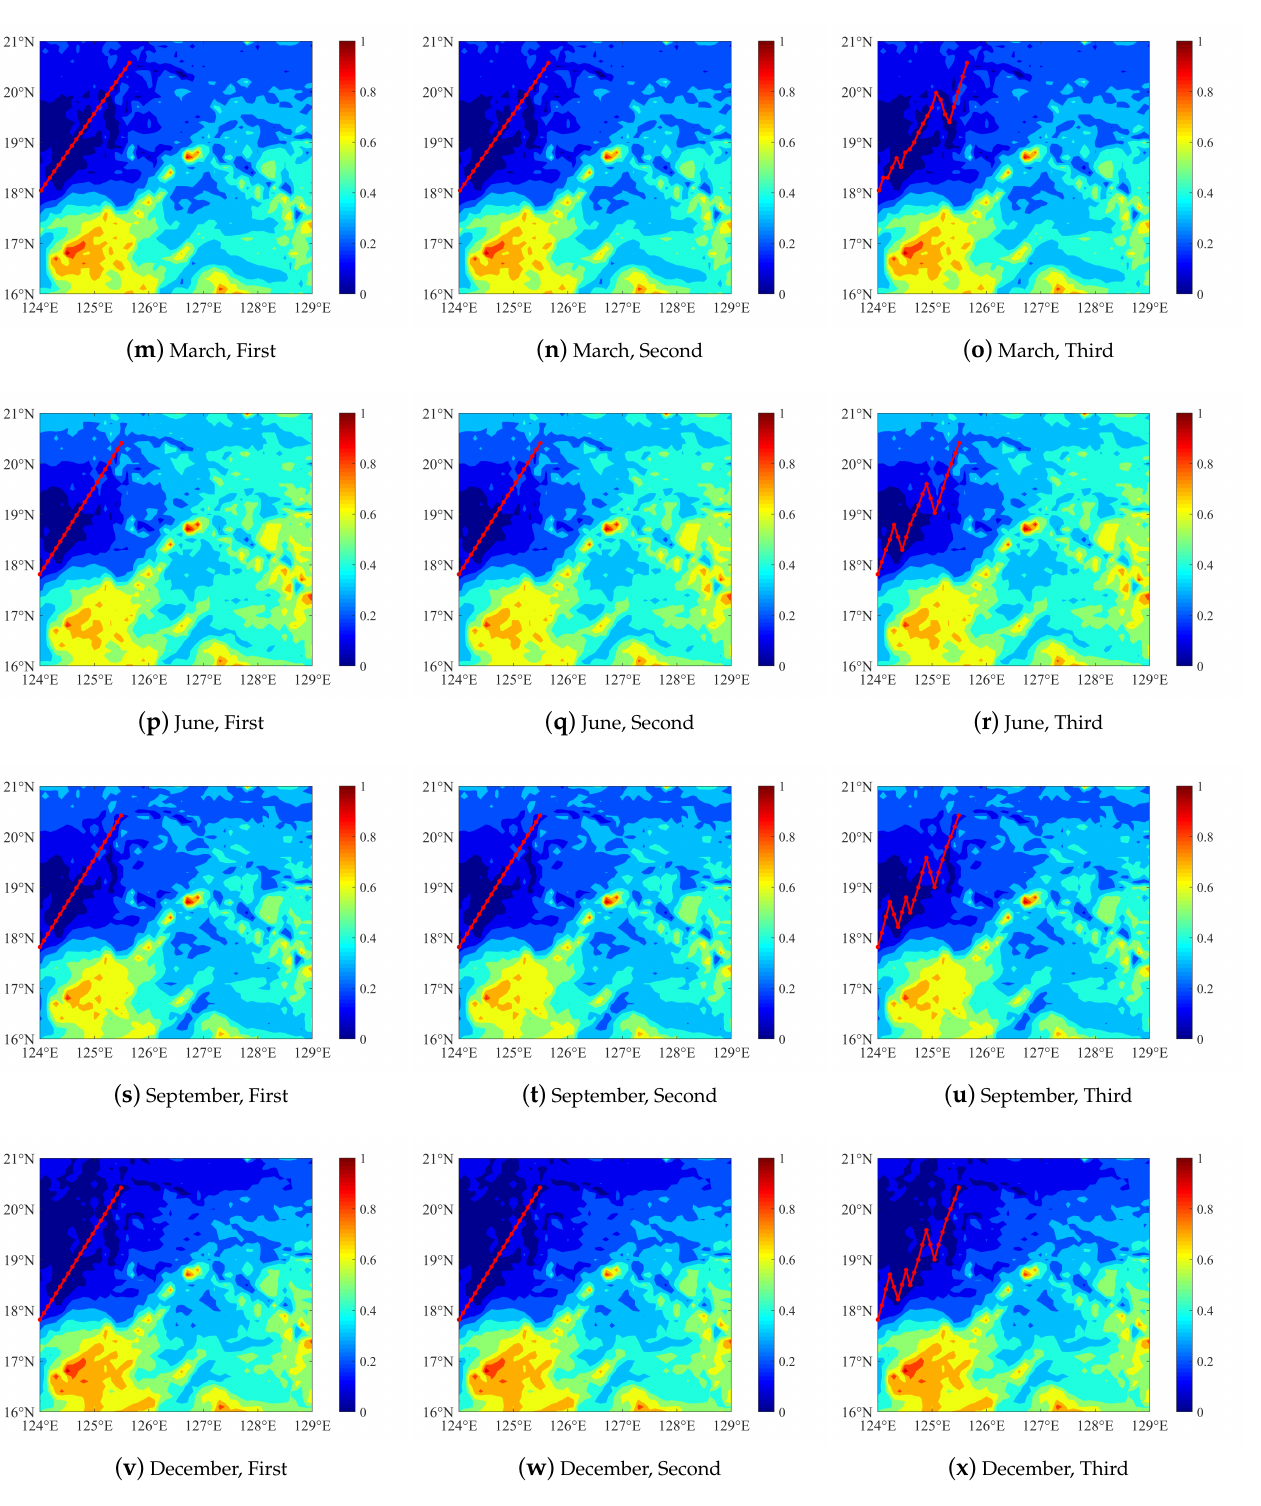
Figure 8. Three optimized observation schemes in different months based on improved cost function. The three-level optimization method proposed can not only be used as a whole, each layer can also be applied to different situations as an independent part. The result of three-level optimization based on improved cost function is useful to find observation path through sampling sensitive location, and it also works under simple terrain conditions (with few